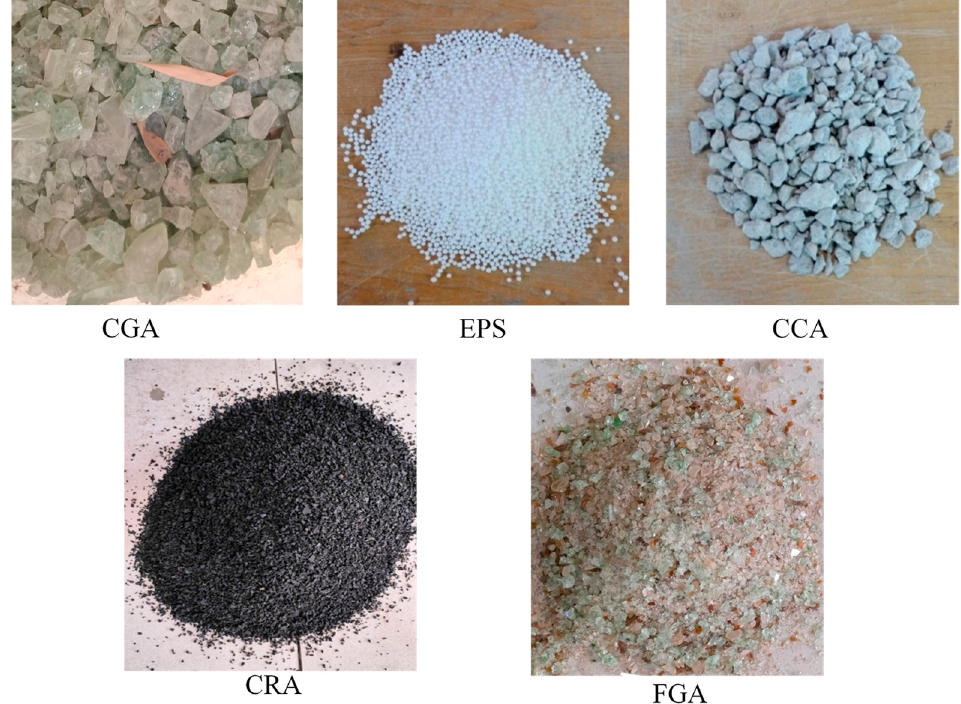
Figure 1. Samples of the recycled